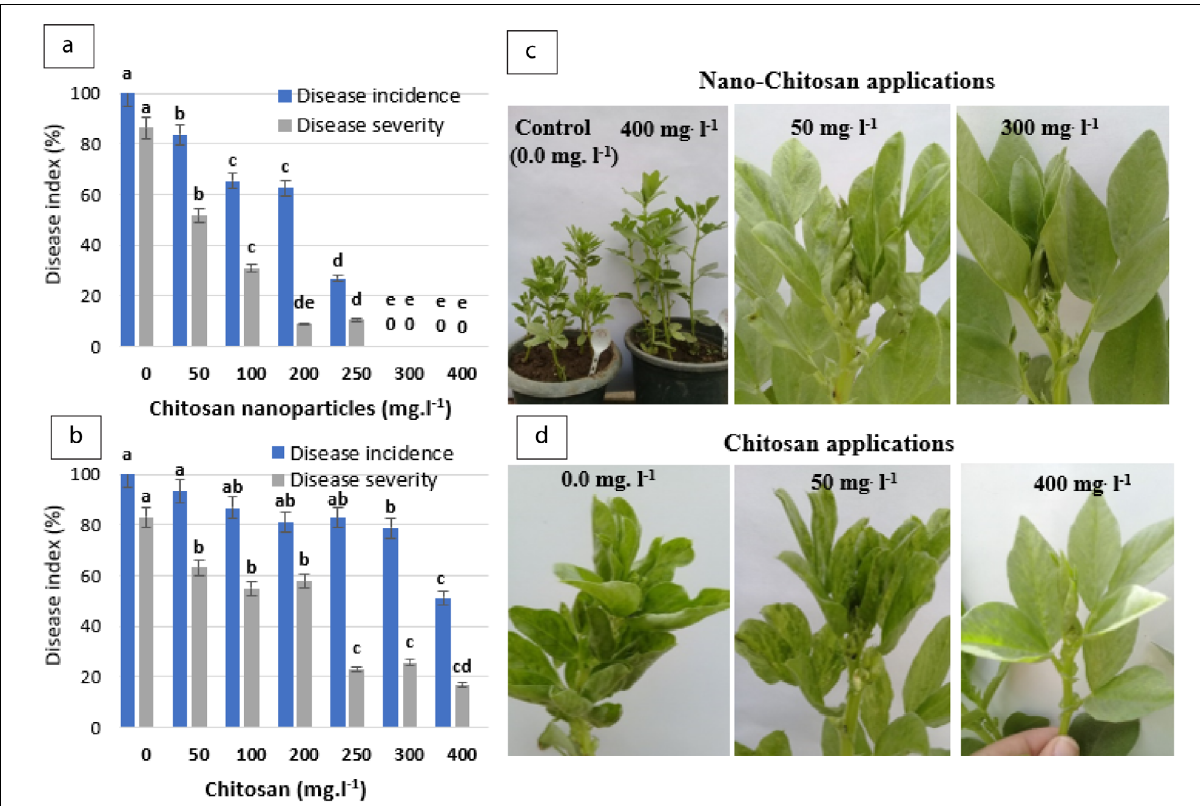
Figure 4: Virucidal activity of (a) chitosan nanoparticles compared to (b) chitosan bulk polymers against Bean yellow mosaic virus disease infectivity on faba bean plants treated with six concentrations compared to untreated control. Disease response scored on foliar treated plants compared to untreated control (c & d). Values with the same letters for each experiment are not significantly different ( p ≤0.05).